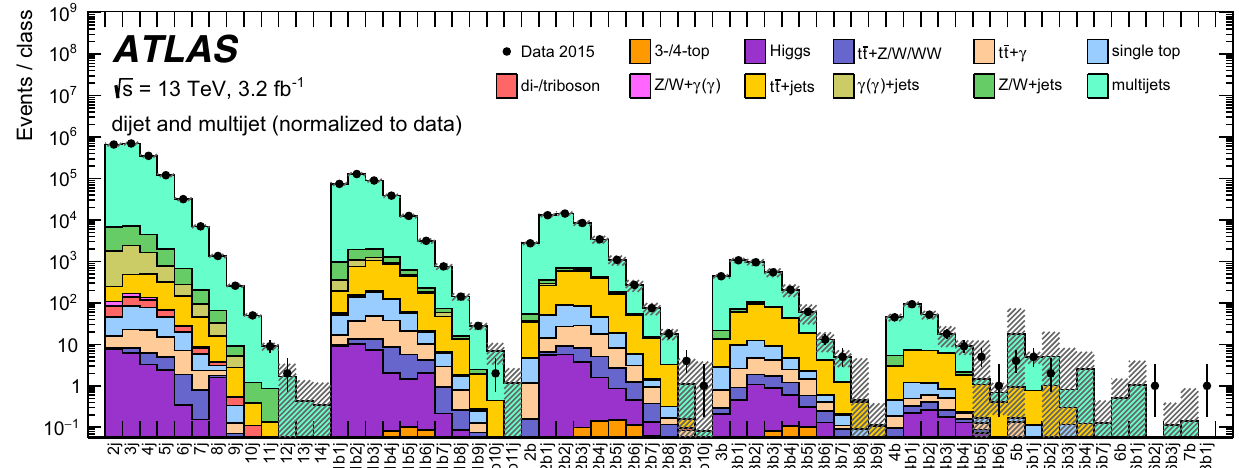
Fig. 23 The number of events in data, and for the different SM back- event class. In event classes with four or more data events, the multi- ground predictions considered, for classes with ( b -)jets (no E miss , lep- jet MC sample is scaled to data. The hatched bands indicate the total T tons or photons). The classes are labelled according to the multiplicity uncertainty of the SM and type ( e , μ , γ , j , b , E miss ) of the reconstructed objects for the given T